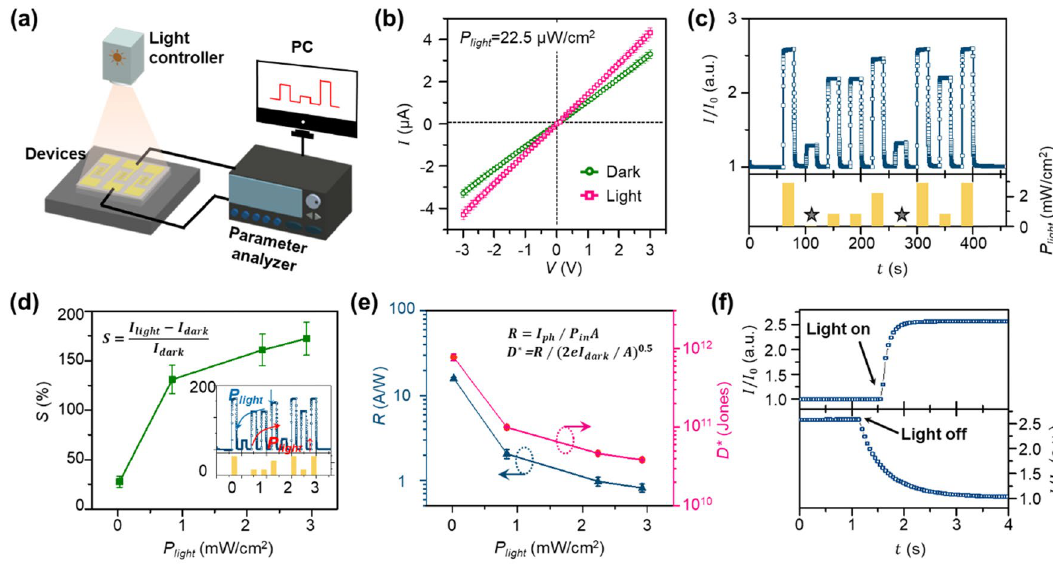
Figure 3. Characterization of the fabricated photodetector. ( a ) Schematics of the measurement set-up. ( b ) The measured I–V characteristics of the device (green circle: dark state, pink square: P light = 22.5 μW/cm 2 ). ( c ) The dynamic optoelectronic response of the fabricated photo-detector (upper panel), and the intensity of incident light (gray solid star: P light = 22.5 μW/cm 2 ). ( d ) The calculated sensitivity ( S ) of the device with respect to various P light (inset: measured S changes by increasing and decreasing P light ). e) The calculated photo-responsivity ( R ) and photo-detectivity ( D * ) of the device with respect to various P light . f) The dynamic response of the photodetector for P light = 22.5 μW/cm 2 ; rise time ( τ r ) and decay time ( τ d ) were 0.329 s and 1.21 s,